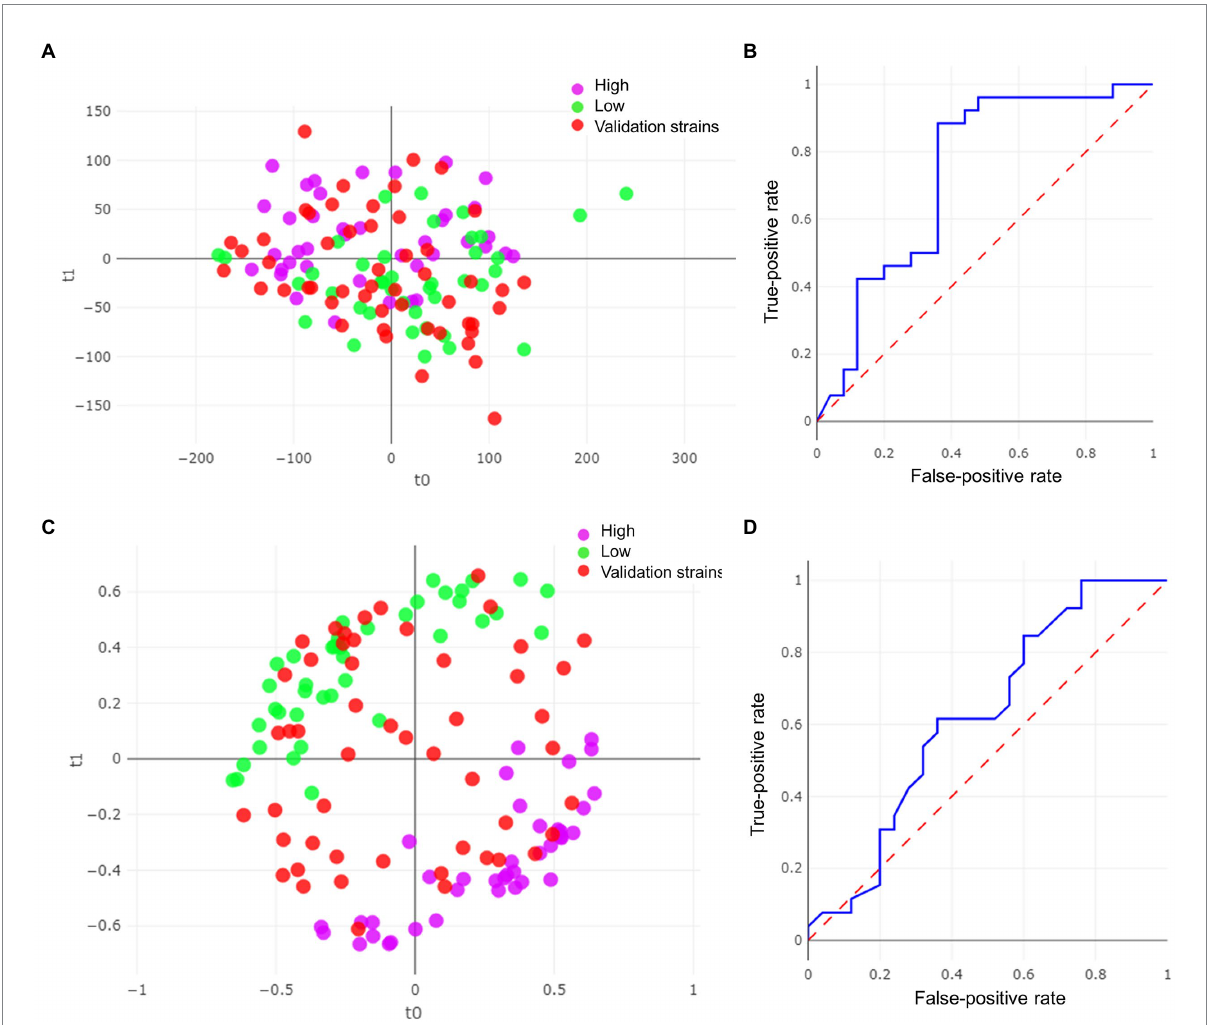
FIGURE 3 Results of the model for Candida albicans strains. (A) Partial least squares-discriminant analysis (PLS-DA) plot with validation strains. (B) ROC curve for PLS-DA model. (C) Random forest (RF) model with validation strains. (D) ROC curve for RF